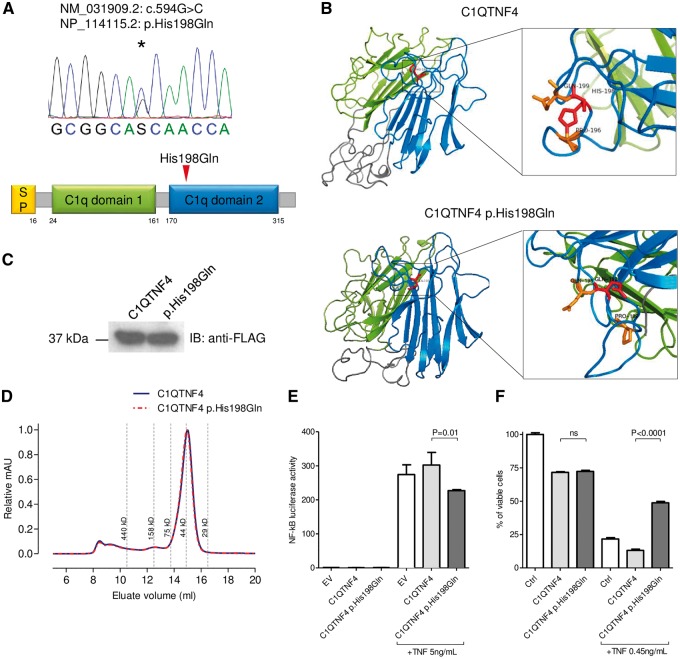
Structural and functional characterization of C1QTNF4 p.His198Gln substitution. (A) Domain organization of human C1QTNF4, showing signal peptide (yellow), first C1q domain (green), second C1q domain (blue) and linker peptides (grey). Arrow highlights substitution site. (B) 3D structure prediction of C1QTNF4 and C1QTNF4 p.His198Gln using Phyre2 (47). Ribbons show the interaction between the positively charged Histidine 198 and Proline 196 lost in C1QTNF4 p.His198Gln due to the substitution of Histidine with Glutamine. (C) Immunoblot demonstrating that p.His198Gln does not affect secretion of C1QTNF4 in HEK293 supernatants. (D) Size exclusion chromatography profile showing no difference in oligomerization between supernatant containing C1QTNF4 (blue) and C1QTNF4 p.His198Gln (red). (E) Luciferase assay in HEK293-NF-κB reporter cell line showing that C1QTNF4 p.His198Gln inhibits NF-κB activation in response to 4 h stimulation with 5 ng/ml TNFα. Error bars represent standard error of the mean. (F) Inhibition of L929 induced cell death by C1QTNF4 p.His198Gln after 24h of stimulation with 0.45 ng/ml TNFα in presence of Actinomycin 1 μg/ml. EV = empty vector.